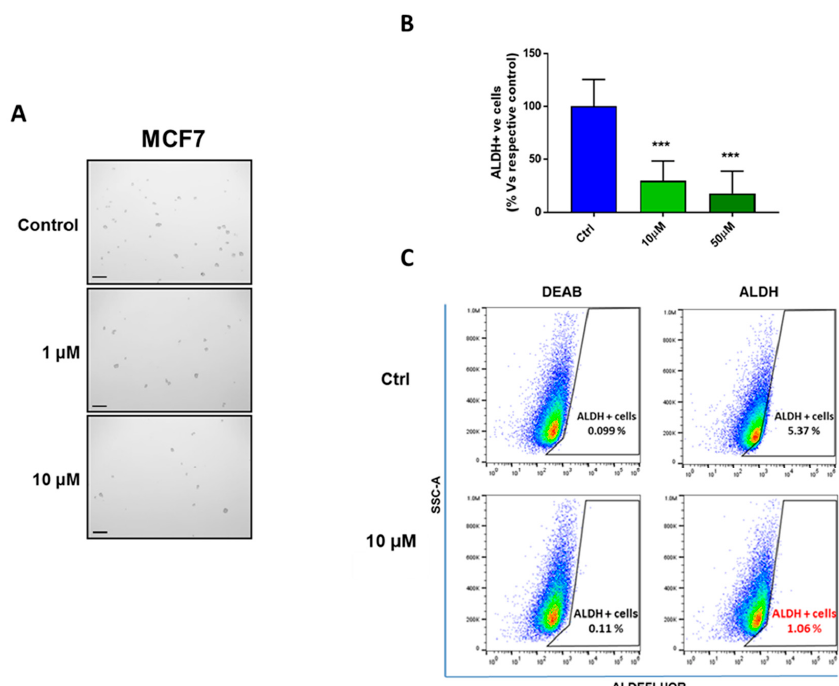
Figure 3. DFP reduces the ALDH activity in MCF7 cells. ( A ) Representative images of CSCs in anchorage-independent growth (control vehicle alone, 1 µ M, and 10 µ M are shown, respectively). A scale bar of 500 µ M is shown. ( B ) ALDH is another established marker of “stemness” and the Epithelial-Mesenchymal Transition (EMT) in cancer cells. Therefore, we used the ALDH activity to further validate the e ff ects DFP on CSCs. Note that 50 µ M of DFP reduced the ALDH activity by > 75% after 5 days of treatment. *** p < 0.0001. ( C ) Representative images of ALDEFLUOR assays performed by FACS (Sony SH800) and analyzed using the FlowJo Software (BD) (control vehicle alone and 10 µ M are shown, respectively). Cells 2020 , 9 , x